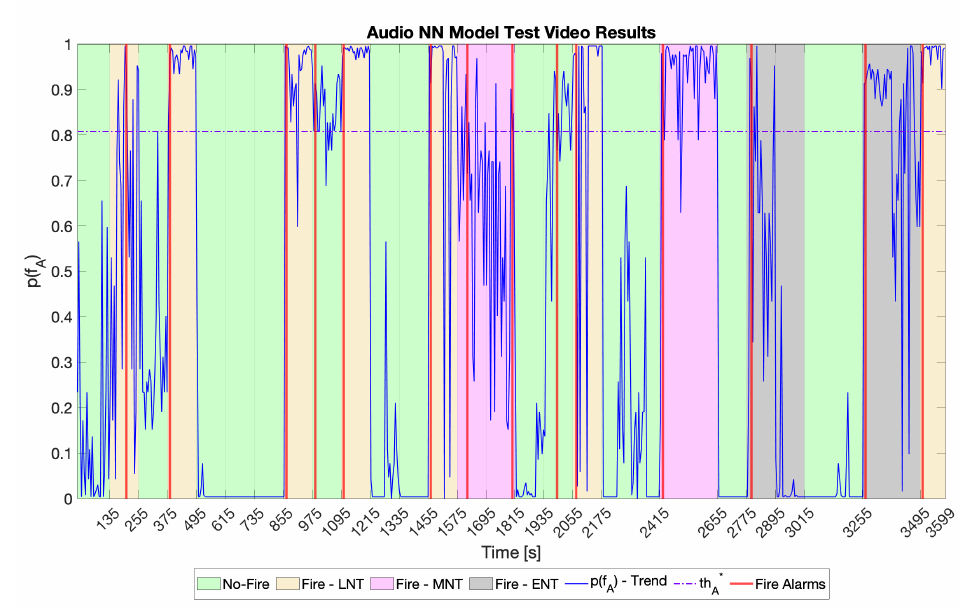
Figure 6. Audio NN model results on the test video. The green areas represent input samples belonging to the “No-Fire” class. The yellow, pink, and grey areas represent input samples belonging to the “Fire” class in LNT, MNT, and ENT, respectively. The solid blue line stands for the trend of p ( f A ) , while the dash-dotted line represents th A ∗ . Finally, the vertical red lines mark the instants at which the audio NN model signalled a fire alarm.